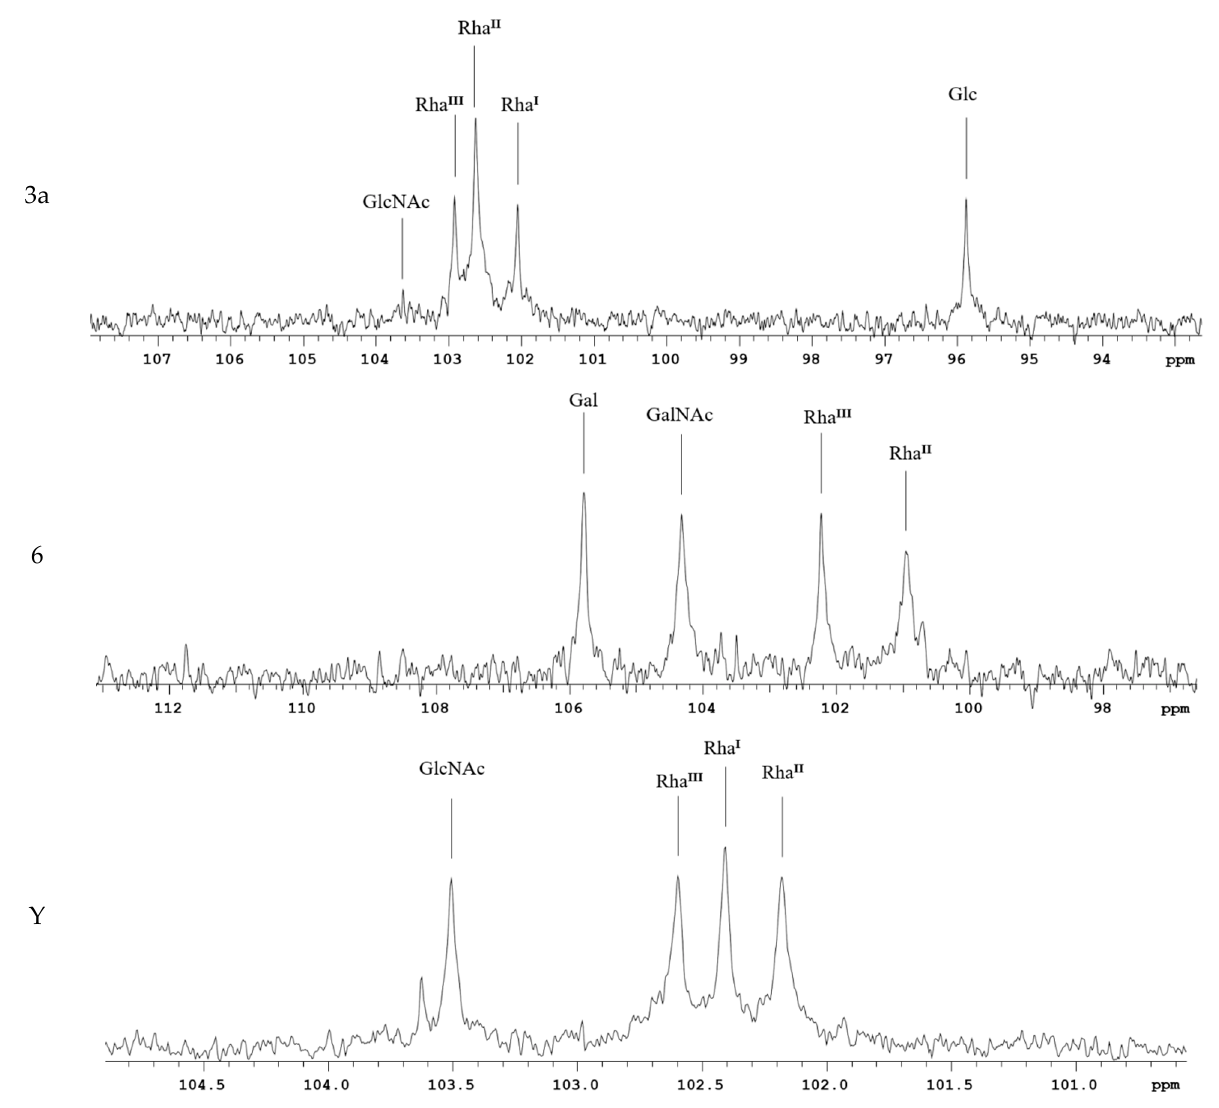
Figure 2. Position of the characteristic signals in the anomeric carbon region of the 13 C NMR spectra of S. flexneri Ac 3 -S-LPS isolated from serotypes 1b, 2a, 3a, 6, and Y. The region for CO resonances is not shown. The assignment of rhamnose signals corresponds to their numbers in the structures (Figure S2).